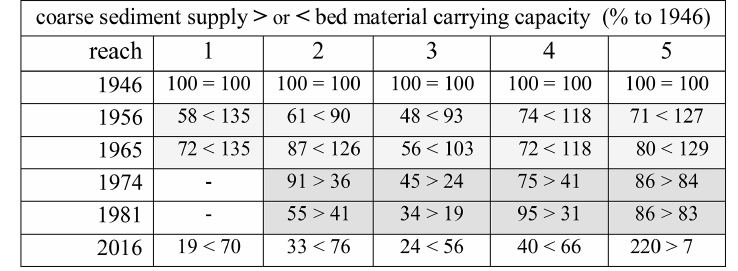
Table 6. Comparison of the amounts of coarse sediment supply (figure left) and bed material carrying capacity (figure right) by reaches and years, with reference to a level 100 of both quantities in 1946.